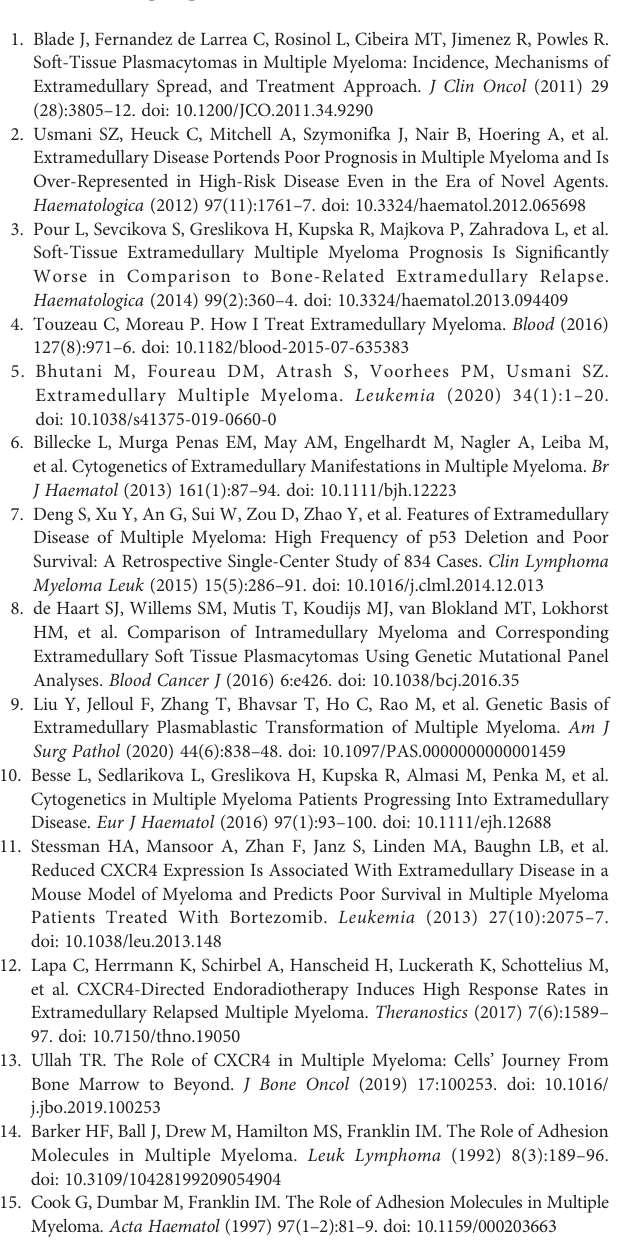
Supplementary Figure 3 | Quanti fi cation method of immunostain for MIF in paired patient samples. Quantitative analysis of MIF staining was as follows (showing a representativepair):wide- fi eldimagesofBMandEMtissueslideswerecapturedwiththe TissueFAXS system (TissueGnostics ), then StrataQuest software (TissueGnostics) was usedtoconvertDABchannelsofMIFstainingintograyscaleimagesandtoevaluatethe mean intensity of MIF in effective positive cells as dot plots show. Supplementary Figure 4 | Supplementary data of the animal experiment. Complete knockout of the MIF gene in ARD cells was veri fi ed by western blot (A) . Flow cytometry analysis showed the in vitro expression of CD138 and MIF in these